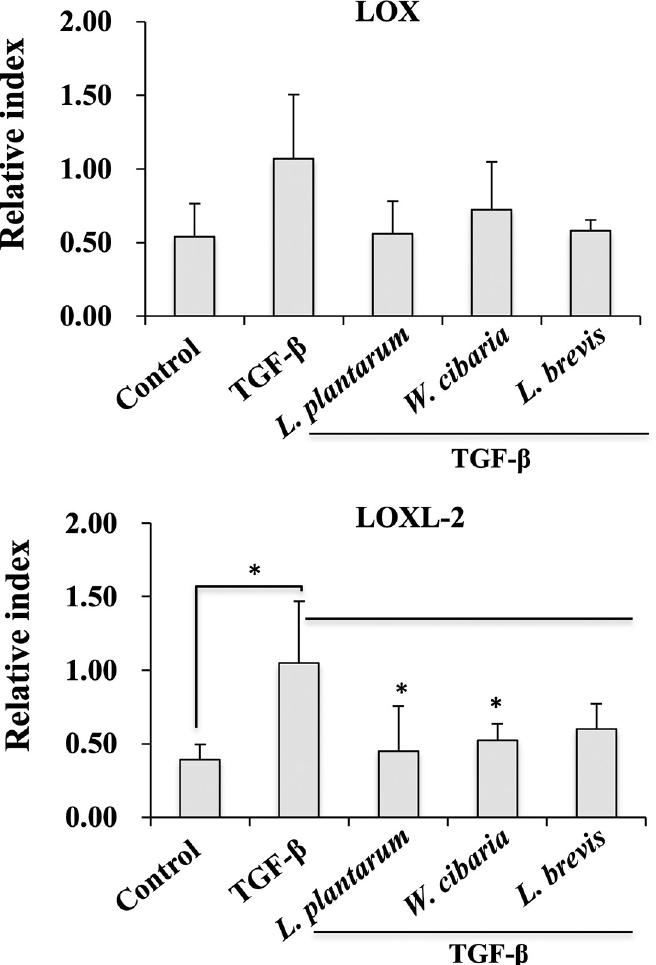
Fig 2. LAB decreased the TGF- β -induced HSCs-activation markers in vitro . Relative mRNA levels of the cell activation markers, such as LOX and LOXL-2 in LX-2 cells after stimulation with the LAB strains and TGF- β . LX-2 cells, either with the medium or TGF- β alone was used as a negative and positive control. Two independent experiments (n = 3) were performed, and the average values (mean + S.D) are shown. � p < 0.05, �� p < 0.01, ��� p <